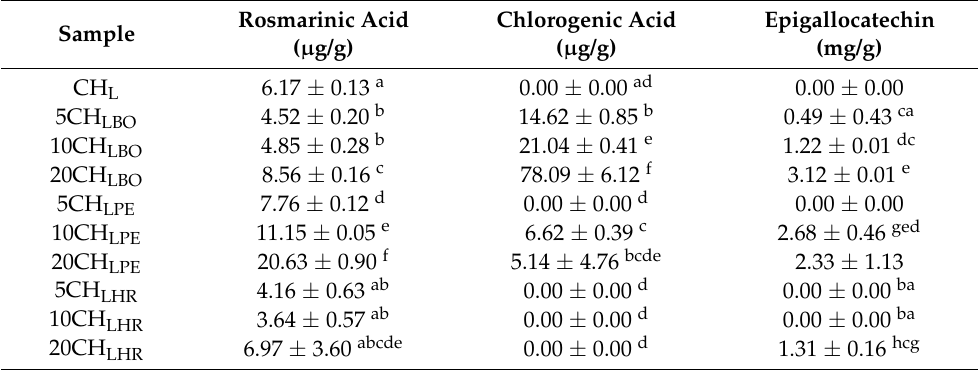
Table 8. Determination of rosmarinic acid, chlorogenic acid and epigallocatechin in chitosan films with addition of blueberry, parsley and red grapes extracts.